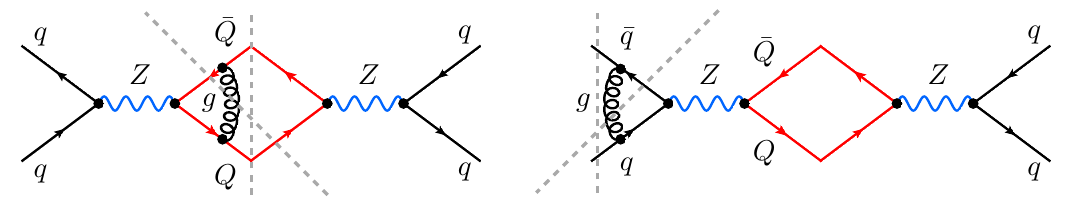
Figure 16 . Possible two- and three-particle cuts that contribute to asymmetric heavy-quark pro- duction at O ( (cid:11) 2 (cid:11) s ). Graphs with photon exchange in the s -channel also give a contribution but are not explicitly shown. See text for additional